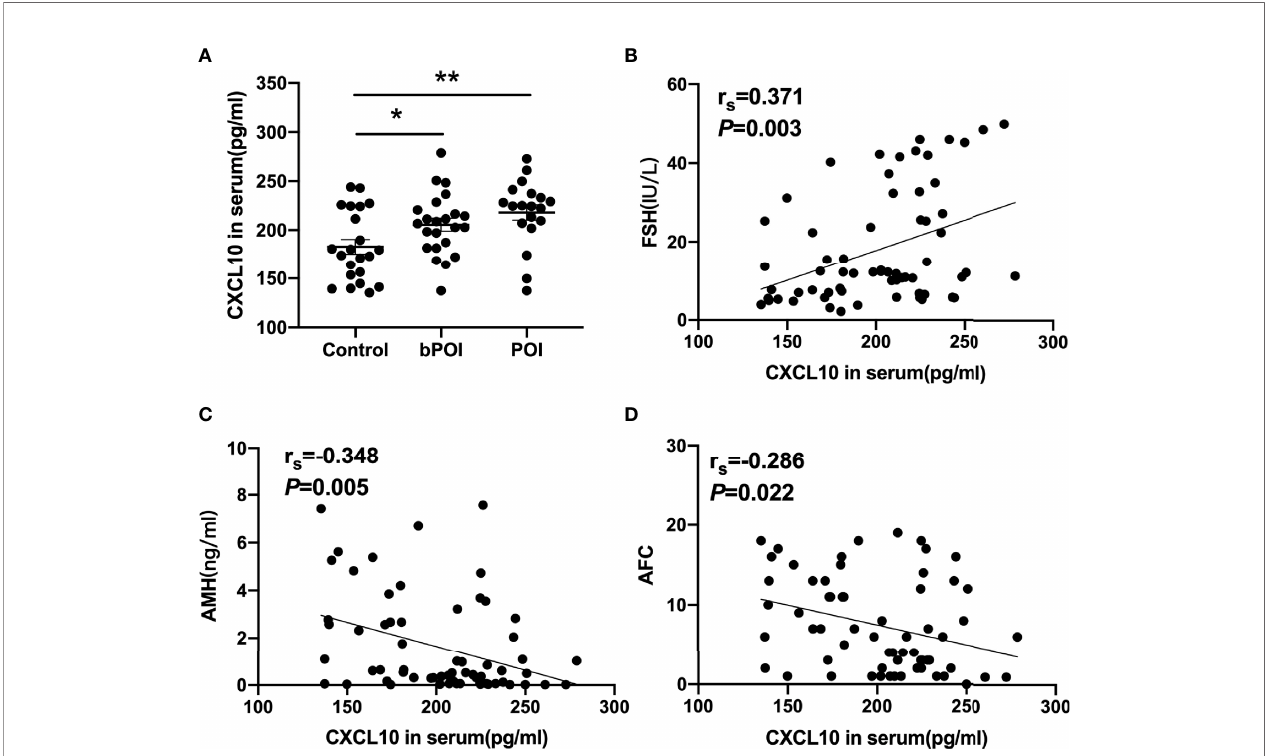
FIGURE 1 | C-X-C motif chemokine ligand 10 (CXCL10) accumulation in the serum of biochemical premature ovarian insuf fi ciency (bPOI) and POI patients. (A) CXCL10 levels in the serum from bPOI patients ( n = 23), POI patients ( n = 19), and control subjects ( n = 22). (B) Positive correlation between serum CXCL10 levels and follicle-stimulating hormone (FSH) levels. (C) Negative correlation between serum CXCL10 levels and AMH levels. (D) Negative correlation between serum CXCL10 levels and AFC levels. * P < 0.05, ** P < 0.01 vs.